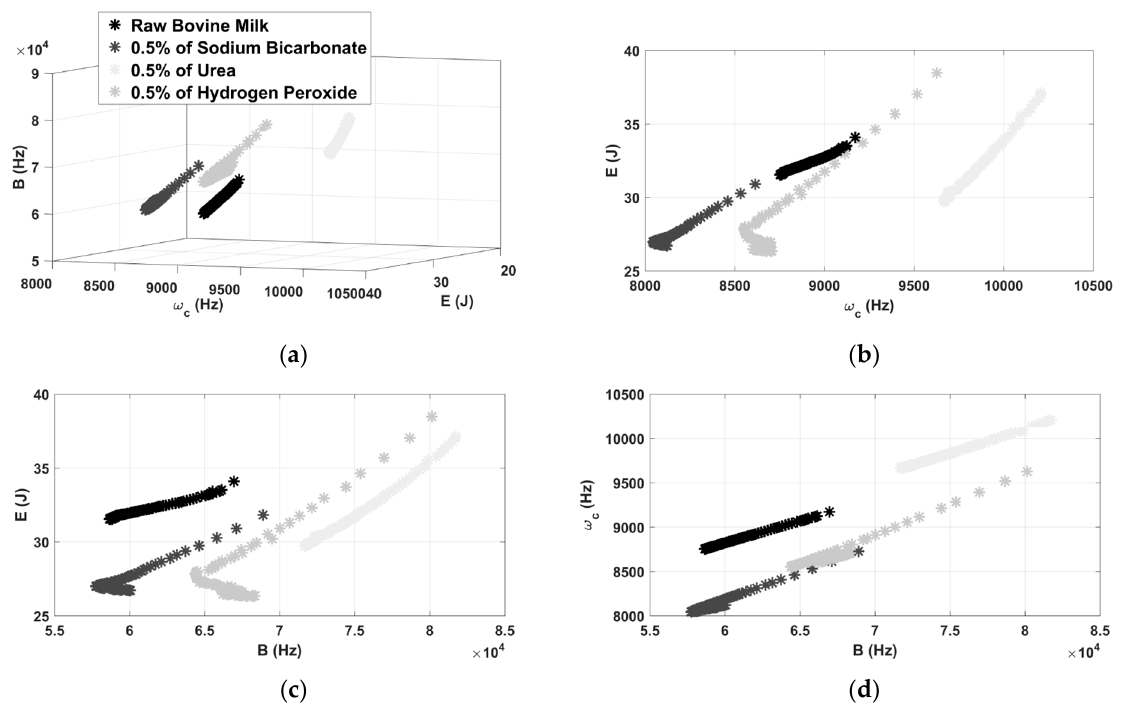
Figure 8. 3D representation of color maps for urea contamination ( a ) and 2D representation of color maps ( b – d ).